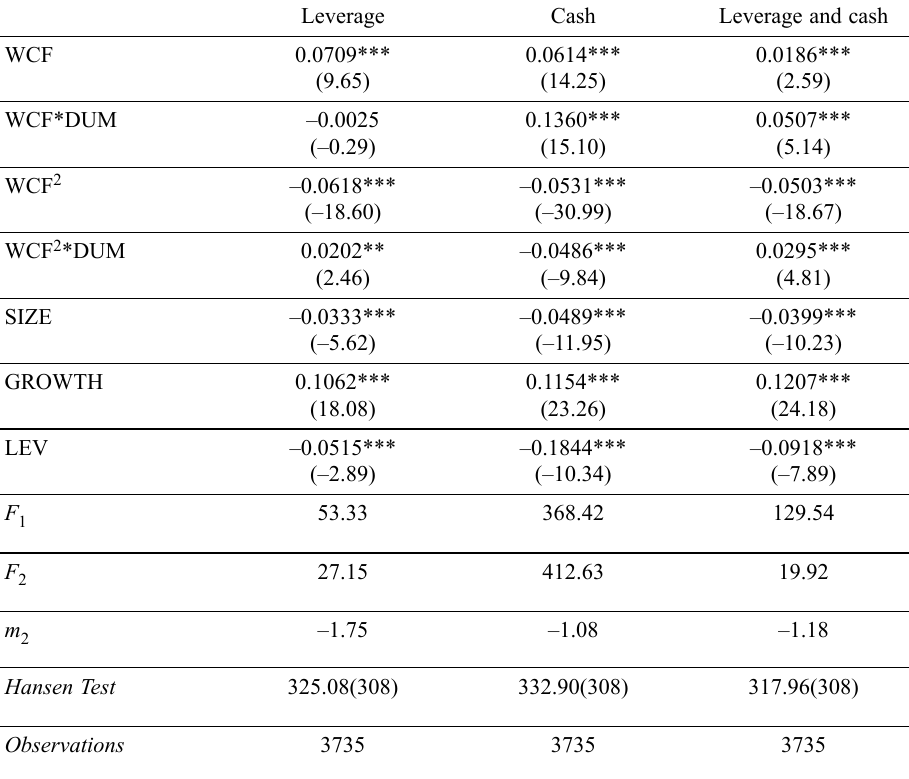
Table 4. Financing of working capital requirement and financial flexibility